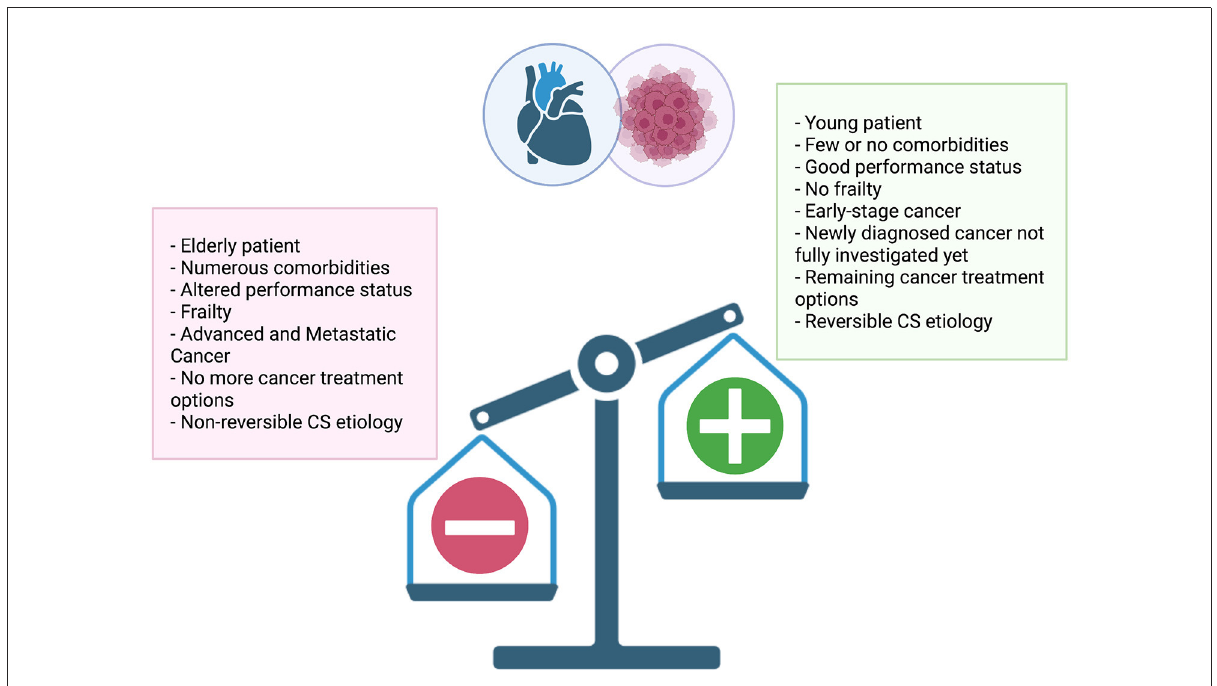
FIGURE2 Multiple criteria to consider when assessing treatment intensity of cardiogenic shock in cancer